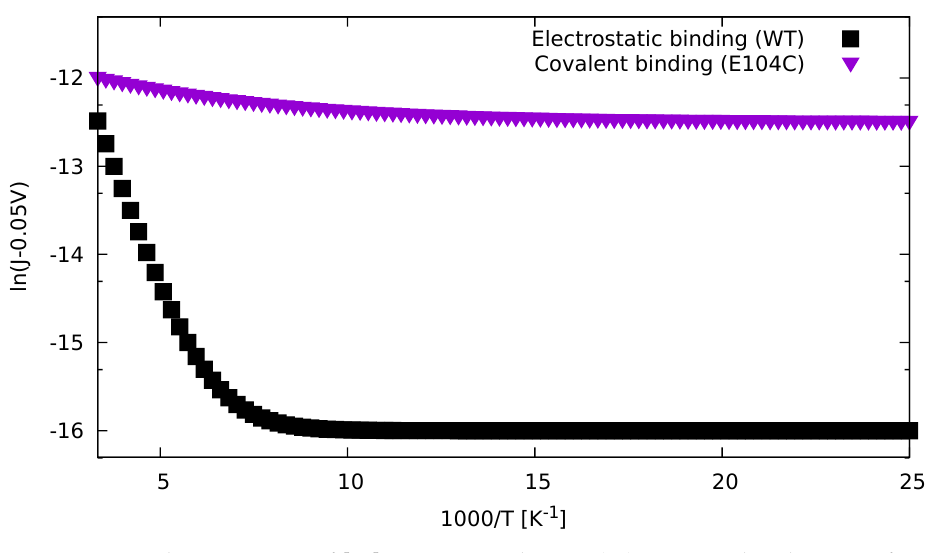
Figure 3. Current density curves of [27] reconstructed using (73). Start and end points of curves visually extracted from original figure. In case of covalent bonding, for activation energy, the gap between LUMO and LUMO+1 energies is used in accordance with (68); whereas, for the electrostatic bonding case, the experimentally found value has been used.